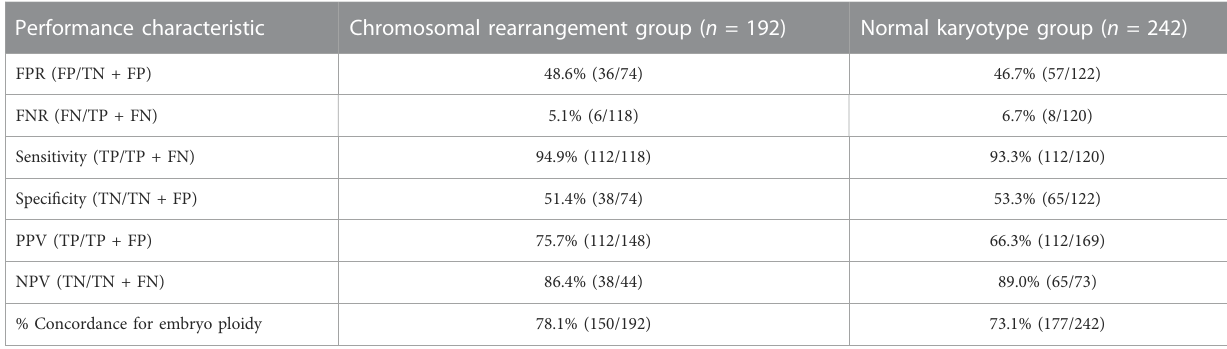
TABLE 1 Comparison of various parameters between the normal chromosome group and rearrangement group.